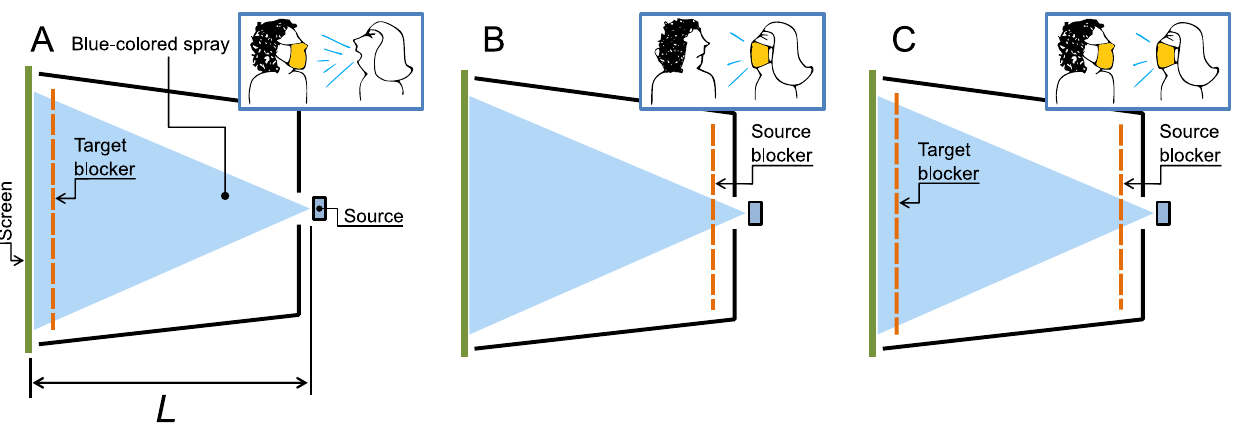
Fig 4. Configurations mimicking real life. (A) CONF1: The target protects herself (himself) using a mask, while the source is unmasked. (B) CONF4: Only the source wears a mask. (C) CONF1+4: Both the source and the target are wearing masks. In all configurations, L = 19 cm. https://doi.org/10.1371/journal.pone.0275376.g004 the air, they just feel the gravitational force and the viscous drag due to the interaction with the air and (b) During the interaction with a blocking cloth, droplets are able to pass through it with a certain probability; in the case they emerge from the opposite side, their velocities would decrease due to viscosity losses. The step-by-step implementation of the model in order to mimic the actual experiments is described below.